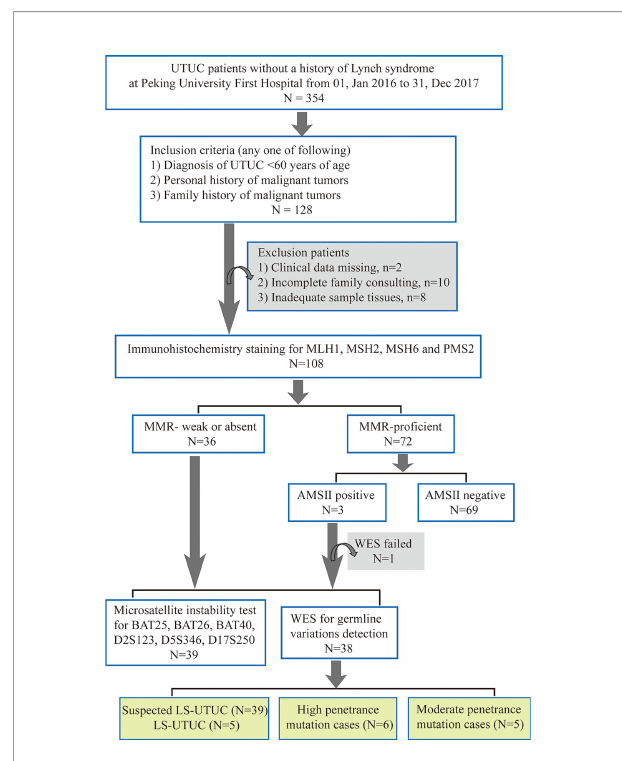
FIGURE 1 | Flowchart of Lynch Syndrome screening. UTUC, upper tract urothelial carcinoma; MMR, mismatch repair; AMS, Amsterdam; WES, whole exon sequencing; LS-UTUC, Lynch Syndrome related